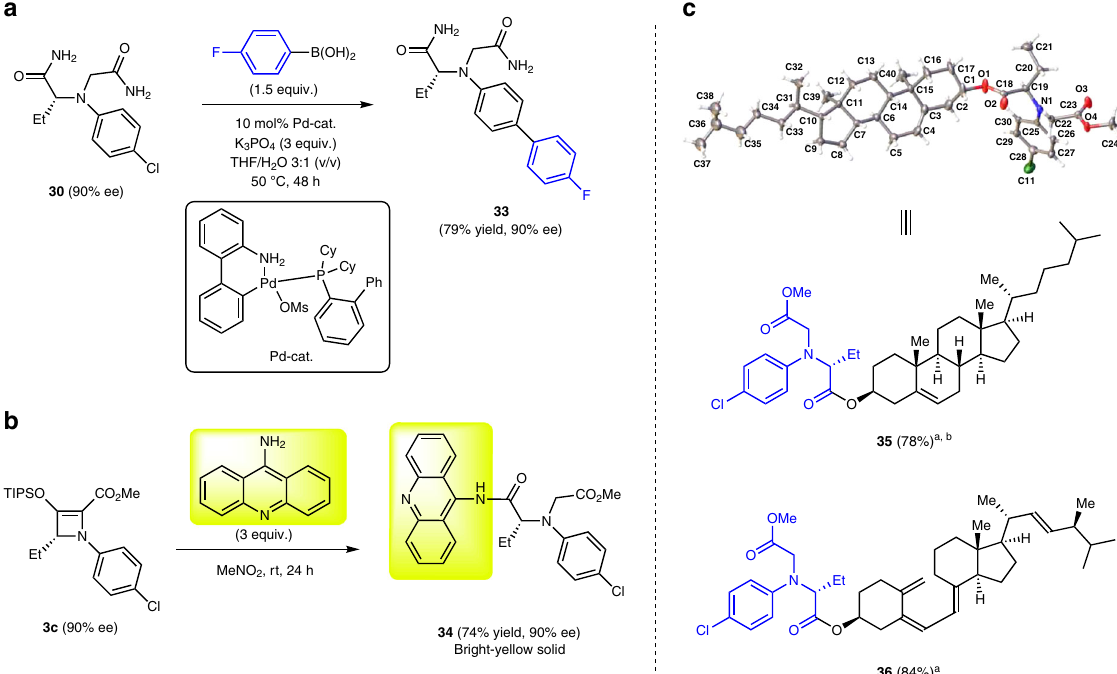
Fig. 5 Functionalization of ring-opened products. a Representative example of Suzuki − Miyaura cross-coupling of a ring-opened product. b Attachment of a fl uorescent unit to chiral amino acid. c Functionalization of cholesterol and ergocalciferol (vitamin D